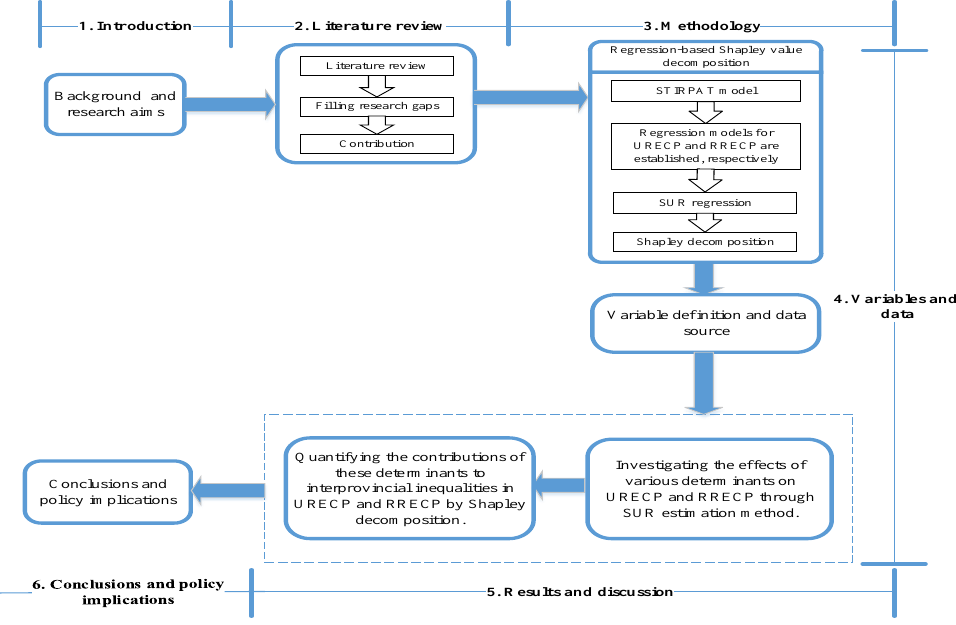
Figure 1. The framework of this study. STIRPAT: the stochastic impacts by regression on population, affluence, and technology; URECP: urban residential energy consumption per capita; RRECP: rural residential energy consumption per capita; SUR: seemingly unrelated regression.